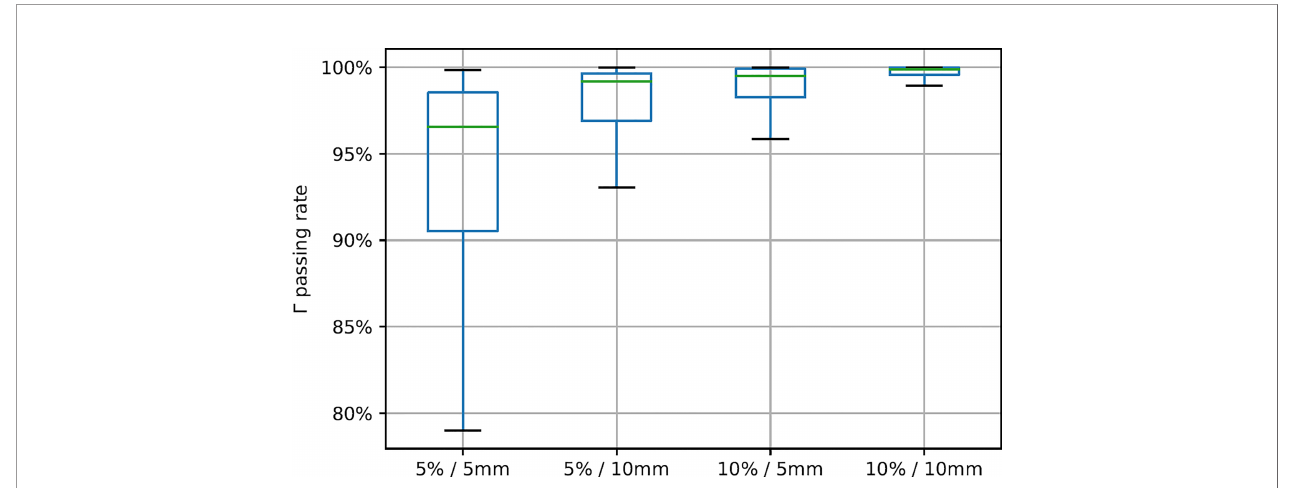
FIGURE 3 | Gamma Index passing rate summary with different gamma criteria. Green line positions represent median value, and box represents 25%/75% percentile with whiskers indicating 5%/95% percentile.